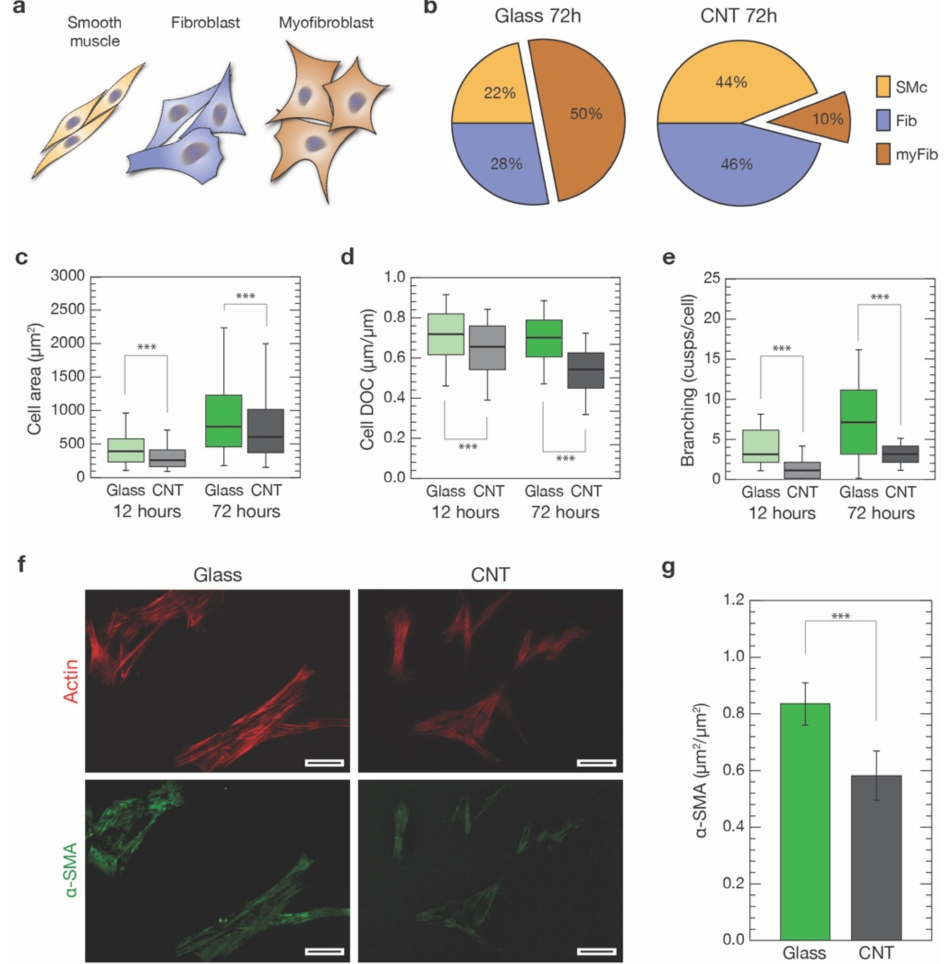
Figure 2. Morphological characterization of VICs grown on control glass and CNTs substrates. ( a ) Based on cell shape and elongation, we identified three distinct cell morphologies within our cultures: a spindle-like shape, associated with smooth muscles cells (SMc, orange), intermediate geometries ranging from unciform to sagittate shapes, associated with fibroblasts (Fib, blue), and large and cuspated shapes, associated with myofibroblasts (myFib, brown). ( b ) Percentages of the three different cell morphologies were evaluated in cultures developed for 72 h on both glass and CNTs. ( c ) Box plot pointing out cell dimensions after 12 h from seeding on glass controls (light green) and CNTs (light grey), and after 72 h (dark green and grey, respectively). ( d ) Degree of circularity (DOC) of cells developed on glass controls and CNTs for 12 and 72 h. ( e ) Number of cusps characterizing cells grown on glass controls and CNTs after 12 and 72 h. ( f ) Two representative fields of α -SMA staining (in green, bottom row) of cells developed for 72 h on glass and CNTs (actin filaments stained in red, top row). The generally lower and grainer fluorescence signal characterizing CNT samples should be noted. Scale bars: 50 µ m. ( g ) Box plot summarizing α -SMA expression, normalized by the actin content, of cells developed interfaced for 72 h to glass substrates (dark green) and CNTs (dark grey). *** p <